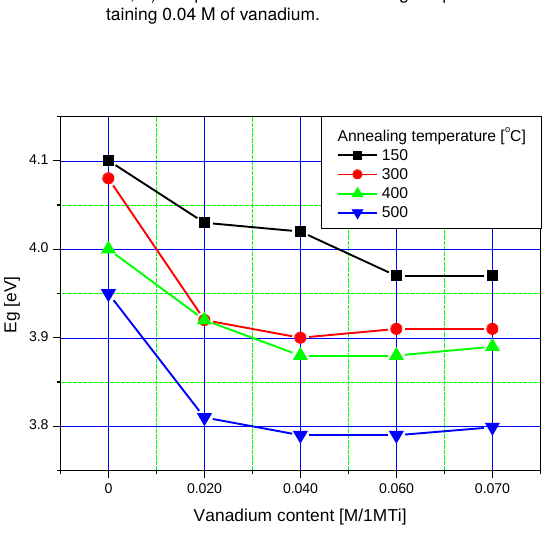
Figure 8. Transmittance spectra of samples with two layers (both sides of glass were covered) of thin film: A) samples with different amount of vanadium annealed at 500 °C during 1 h; B) samples with different annealing temperature con- taining 0.04 M of vanadium.